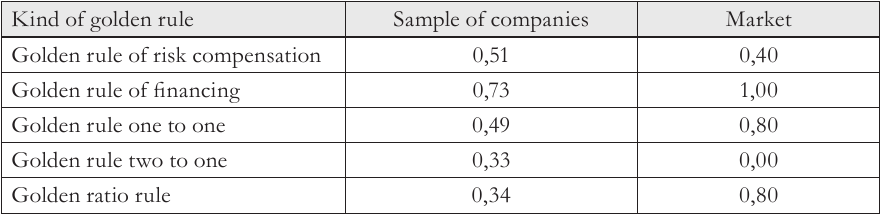
Tab. 5 – Comparing probability of respecting golden rules of financing by companies within the sample, regardless the period and phase of their life cycle, and by the whole market. Source: own research.